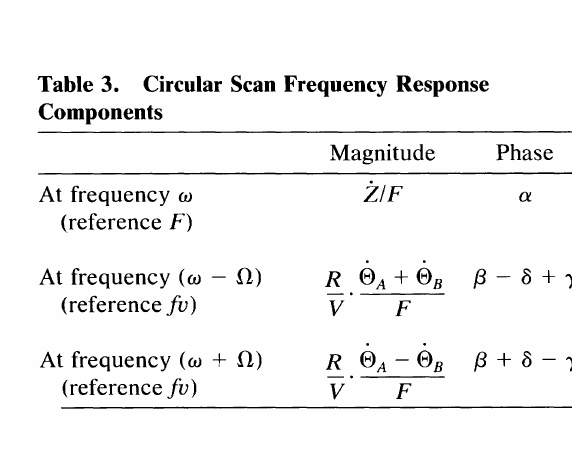
FIGURE 7 Test cube, circular scan.